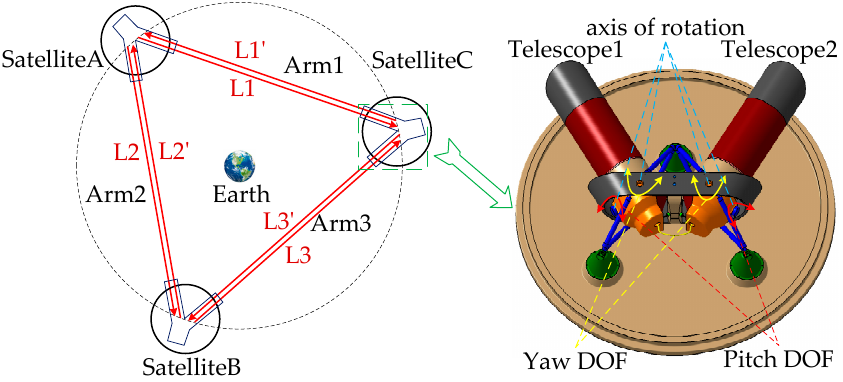
Figure 2. Control of the telescope pointing DOFs. ( a ) Three attitude DOFs and one telescope DOF; ( b ) Each telescope has two DOFs.